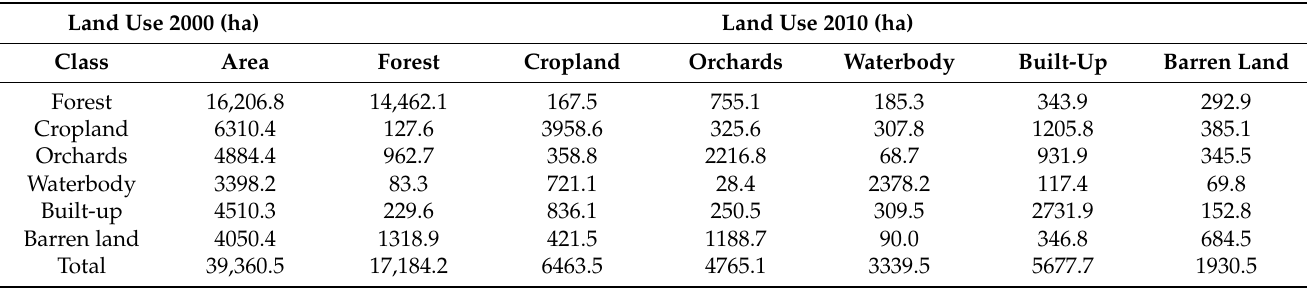
Table 6. The transformation matrices for changes of LULC classes from 2000 to